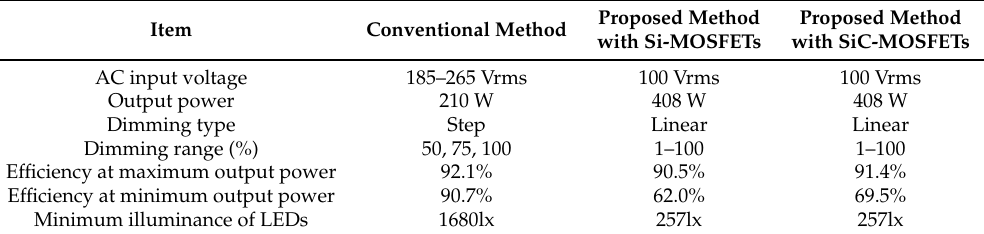
Table 3. Comparison between the conventional and proposed